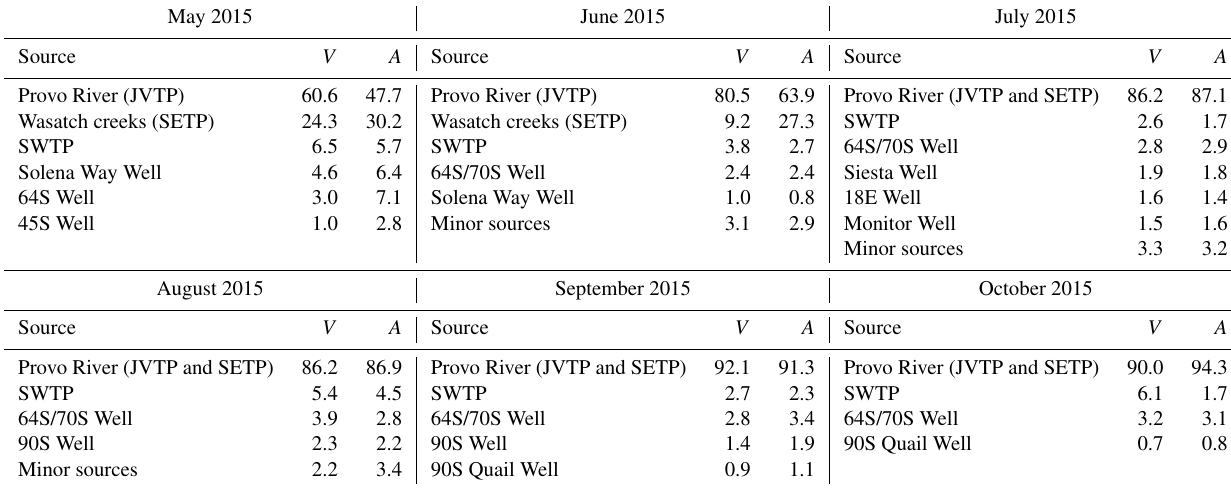
Table 2. Comparison between volumetric ( V ) and areal ( A ) contributions of the different sources from May to October 2015. V for each source was calculated from the monthly supply data of each source (see Table 1). A was calculated using methods described in Sect. 2.5. JVTP and SETP are considered as separate sources in May and June 2015 and combined sources from July to October 2015. Sources contributing less than 1% of the total volume have been grouped together as “minor sources” for June, July, and August 2015. All values are in